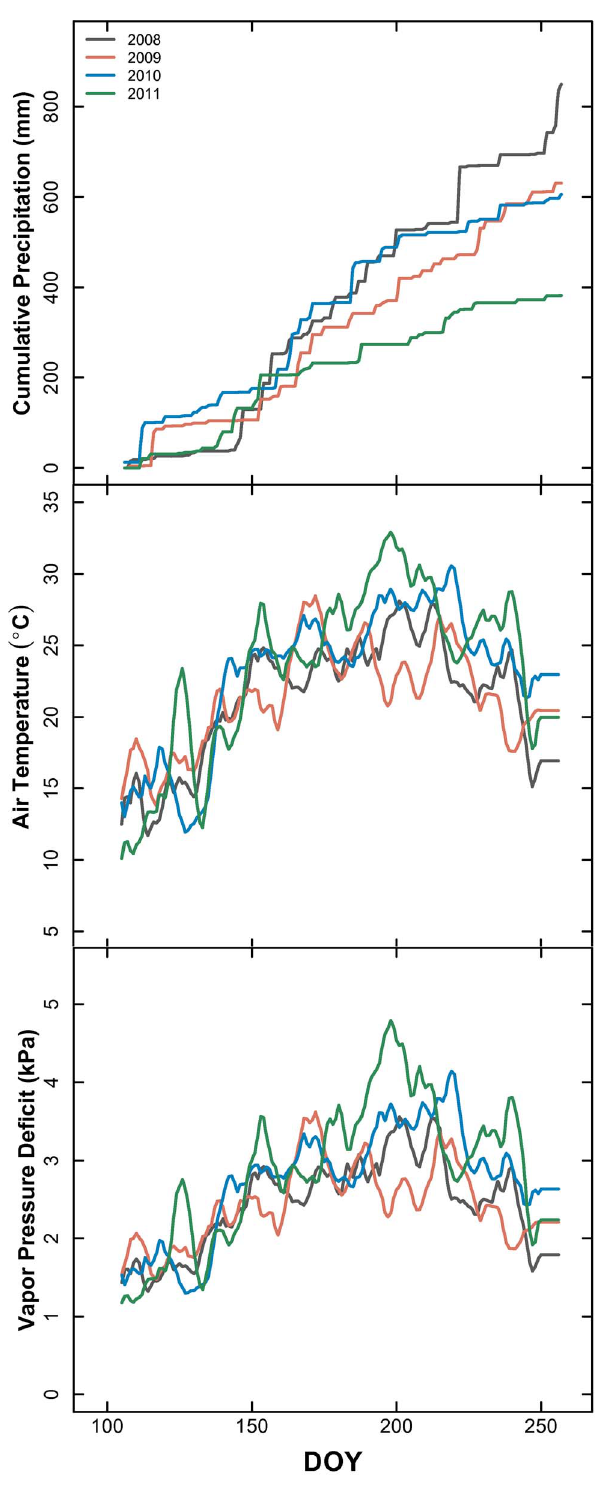
Figure 1. Konza climate from DOY 105–259 for the four years of this study: a – cumulative precipitation (mm); b – mean daily air temperature ( 6 C); c – mean daily vapor pressure deficit (kPa).